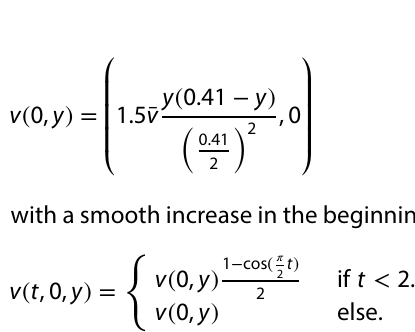
Fig. 7 Velocity magnitude in Ω f at three different times for the vis- coelastic FSI3 case